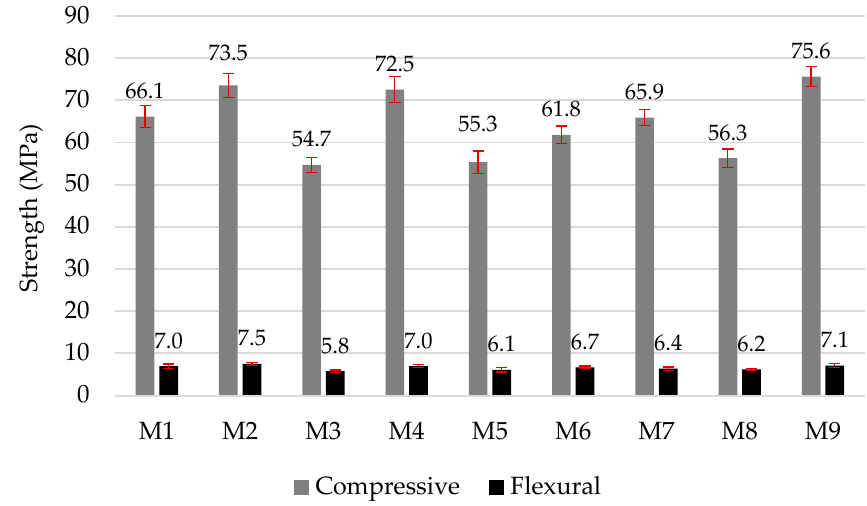
Figure 6. Compressive and flexural strengths of mortars at 28 days.